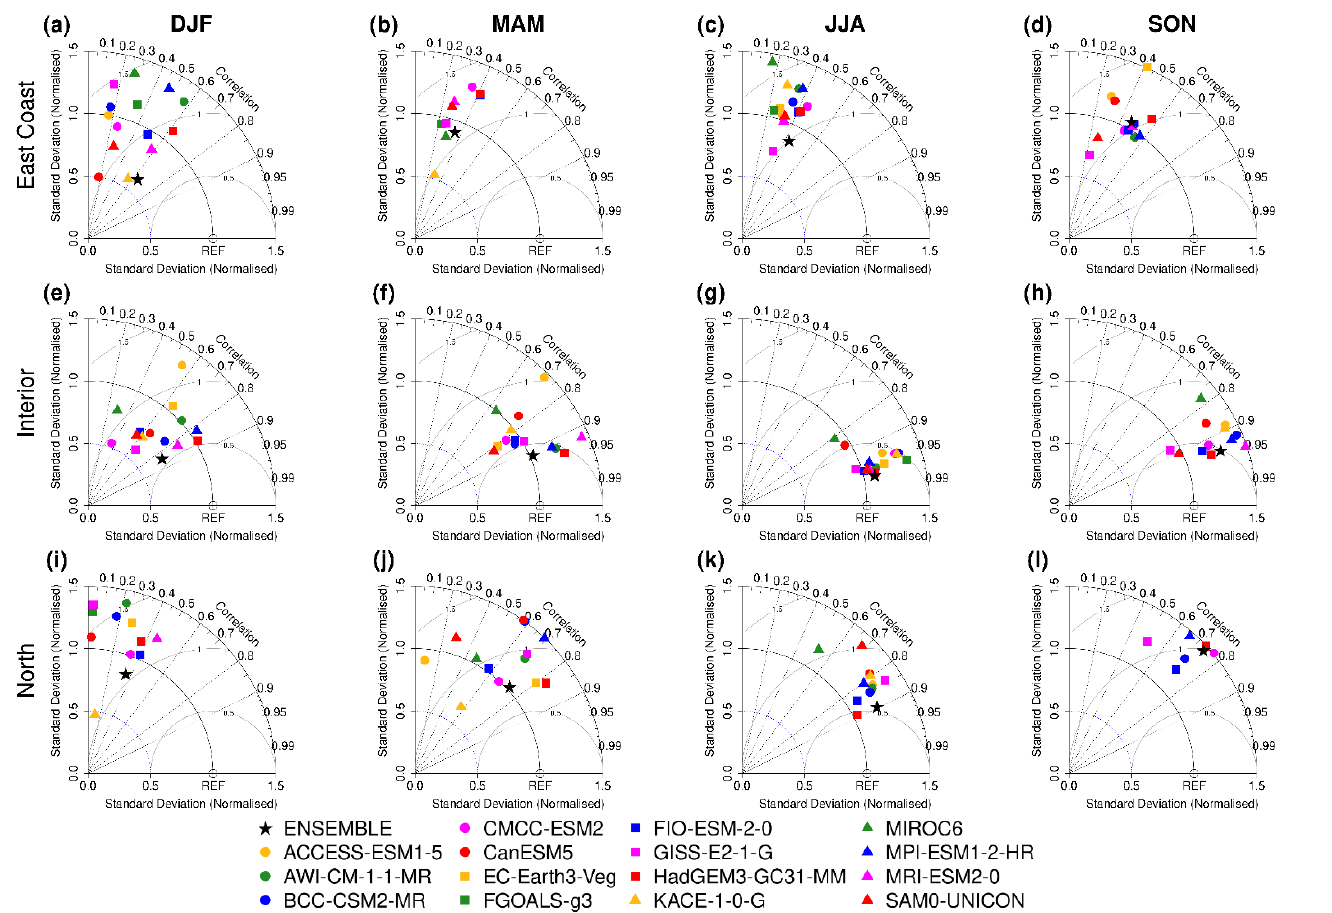
Figure 7. Taylor diagram analysis of seasonal near-surface air temperature averaged over the East Coast ( a – d ), Interior ( e – h ), and North ( i – l ) of the NEB, for 15 CMIP6 models in DJF (first column), MAM (second column), JJA (third column), and SON (fourth column). The term “REF” indicates the reference data from 1980 to 2014.